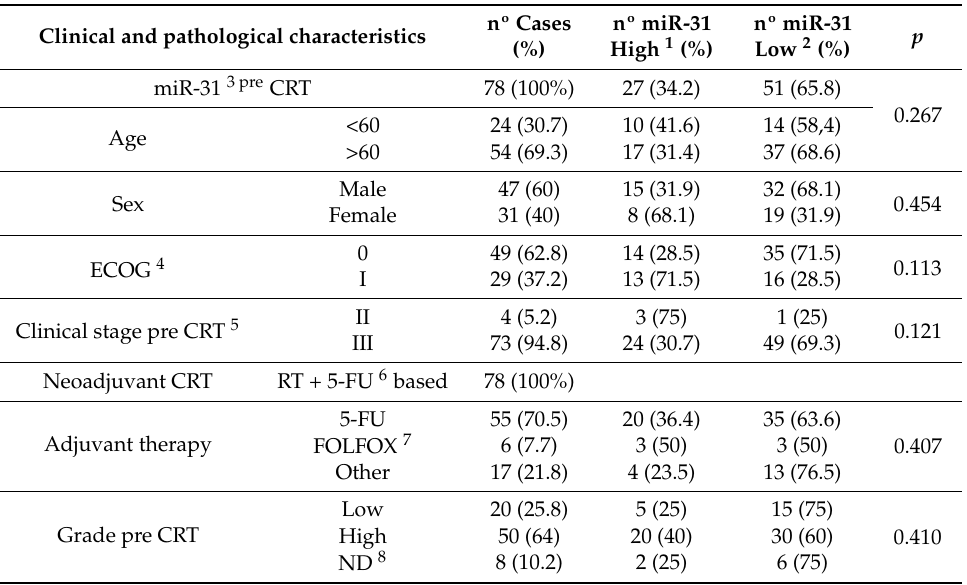
Table 1. Baseline clinical and pathological characteristics of our locally advanced rectal cancer (LARC) cohort and its relation with miR-31 expression.